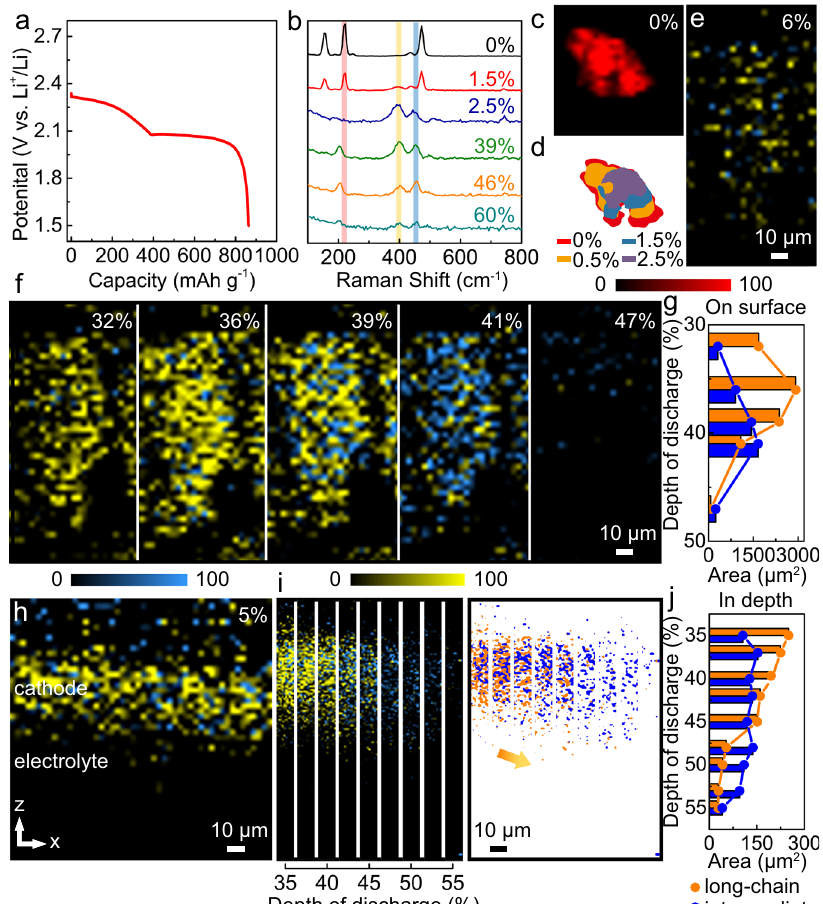
Fig.4| Operando confocalRamaninvestigationofLi – Sredoxprocessesduring the initial galvanostatic discharge process. a Voltage pro fi le, operando Raman ( b )spectraand c – j mappingresultsofsulfurandpolysul fi desduringdischargeata rate of 0.02C (1C=1672mAh g − 1 ). The red, yellow, and blue colors in mapping images represent sulfur, polysul fi de S x 2 − , x =6 – 8, and 3 – 5, respectively. The color contrasts remained consistent for comparison. Different DODs are indicated with %. d areachangesofthepristinesulfurclustersatdifferentDODs. f Onsurfaceand